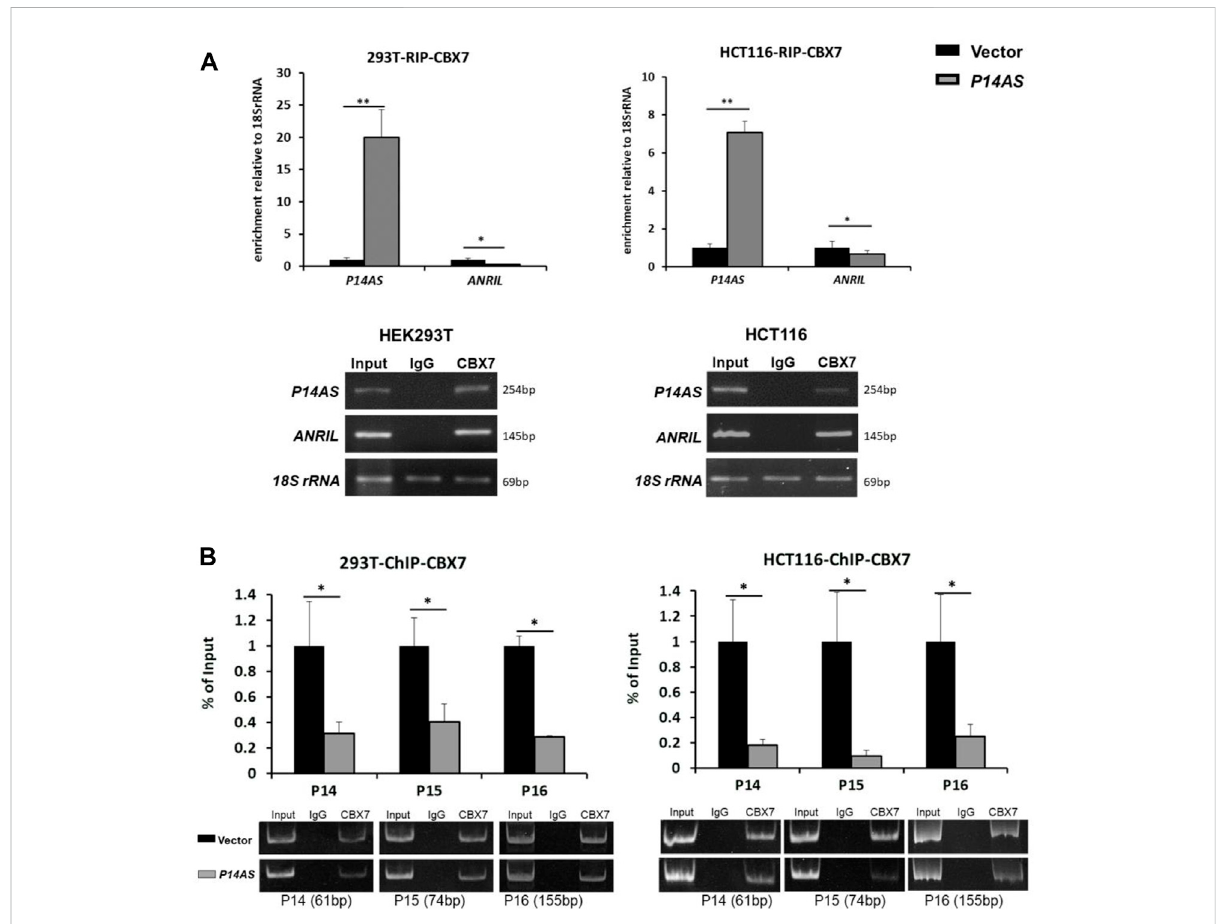
FIGURE 6 P14AS competitively binds to CBX7 and prevents the binding of CBX7 to ANRIL and to P14 ARF , P15 INK4B , P16 INK4A promoters. (A) Levels of P14AS and ANRIL binding to endogenous CBX7, as determined by RIP-qPCR analyses; and (B) binding of gene promoters to endogenous CBX7, as determined by ChIP-qPCR analyses . The experiments were repeated using both HEK293T and HCT116 cell